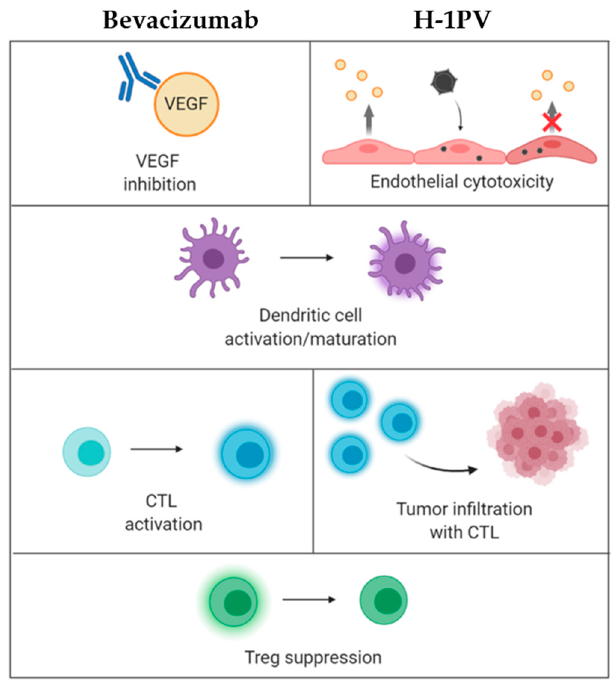
Figure 3. Rationale for combining H-1PV administration with bevacizumab treatment in patients with recurrent glioblastoma multiforme (GBM). Bevacizumab antibody and H-1PV infection share the capacity for inhibiting vascular endothelial growth factor (VEGF) (production) (upper row) and triggering distinct immuno-modulations (lower rows), raising hopes to improve antitumor immunity by combining both treatments. In support of this strategy, bevacizumab and H-1PV were found to jointly achieve significant clinical improvement in GBM patients at second or third recurrence, leading to remission of the recurrent tumor. The precise mechanisms of this therapeutic potentiation remain to be determined. However, the establishment by H-1PV of an immunologically “improved” proinflammatory background, which facilitates bevacizumab-mediated immuno-stimulating effects, is a likely scenario. For details and references, see the main text.